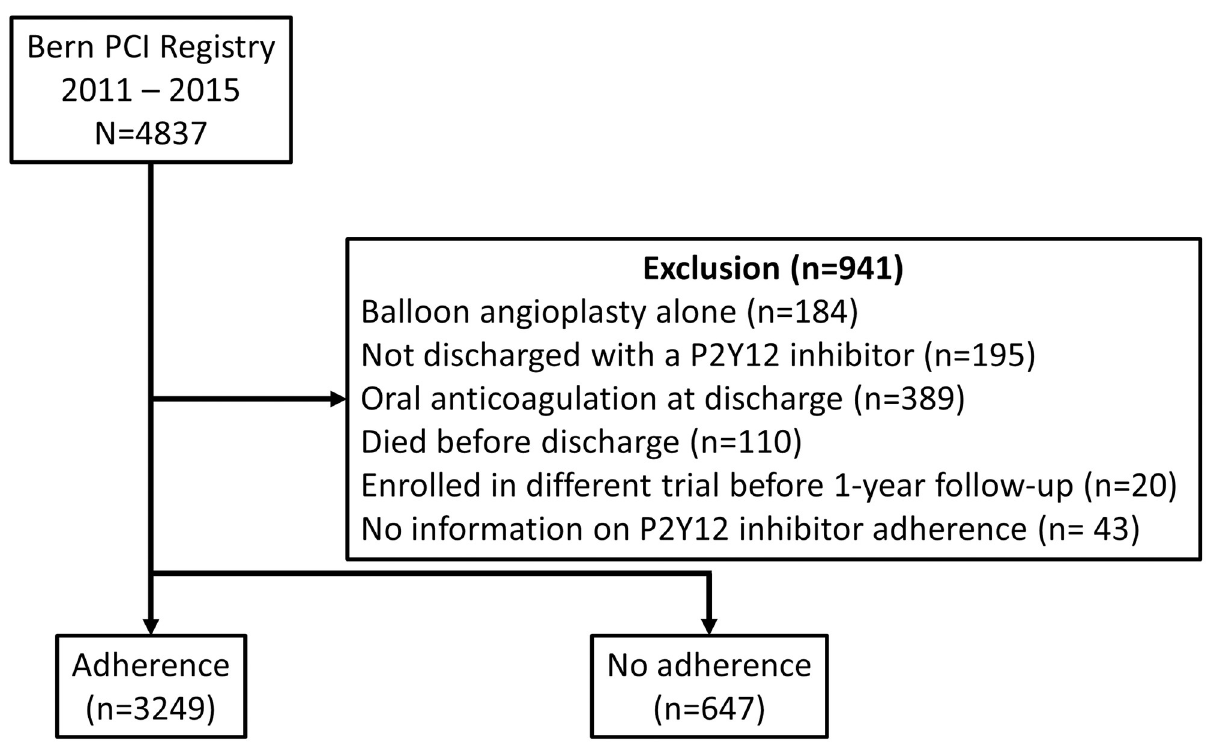
Fig 1. Patient flow. DAPT = dual antiplatelet therapy, PCI = percutaneous coronary intervention.